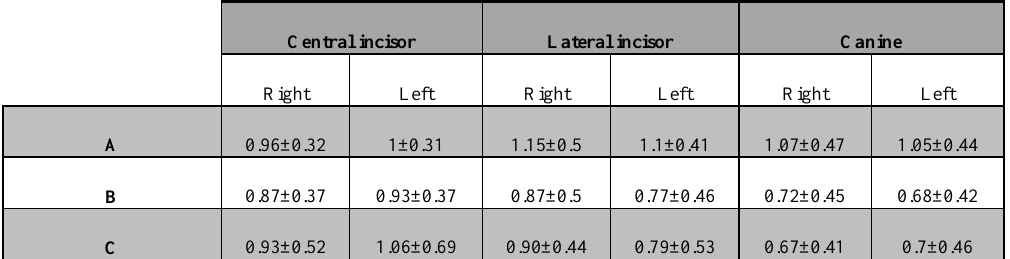
Table 2. Mean facial plate thicknesses (mm)across measurement points per